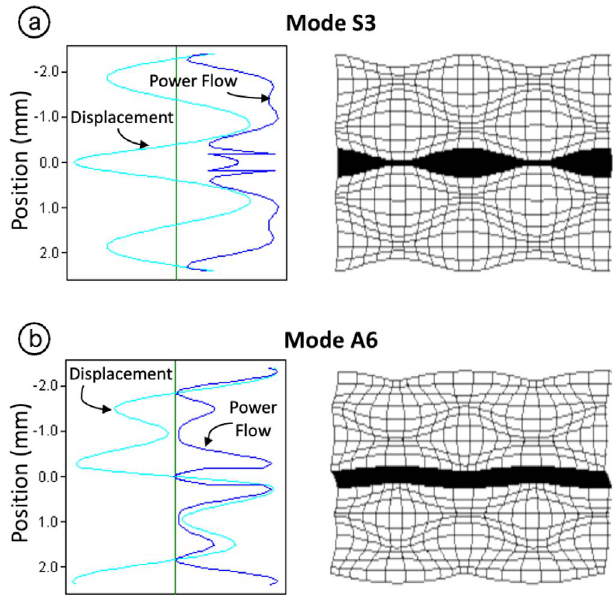
Figure 10. Power fl ow, particle displacement distribution and mode shape of (a) S3 and (b)